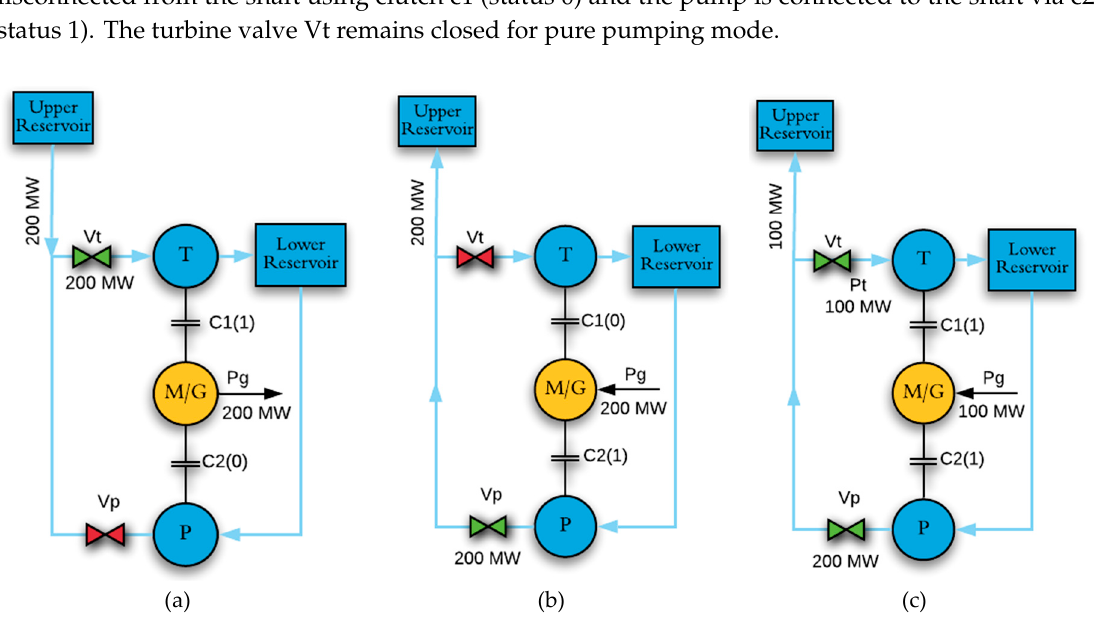
Figure 2. Modes of operation of ternary pumped storage hydro (TPSH) with the status of valves and clutches: ( a ) Generator mode; ( b ) pure pump mode; and ( c ) hydraulic short circuit mode (HSC). Clutches c1 and c2 are either in open mode (status 0) or closed mode (status 1). The turbine valve Vt and pump valve Vp are either in the open mode (status green) or in the closed mode (status red).